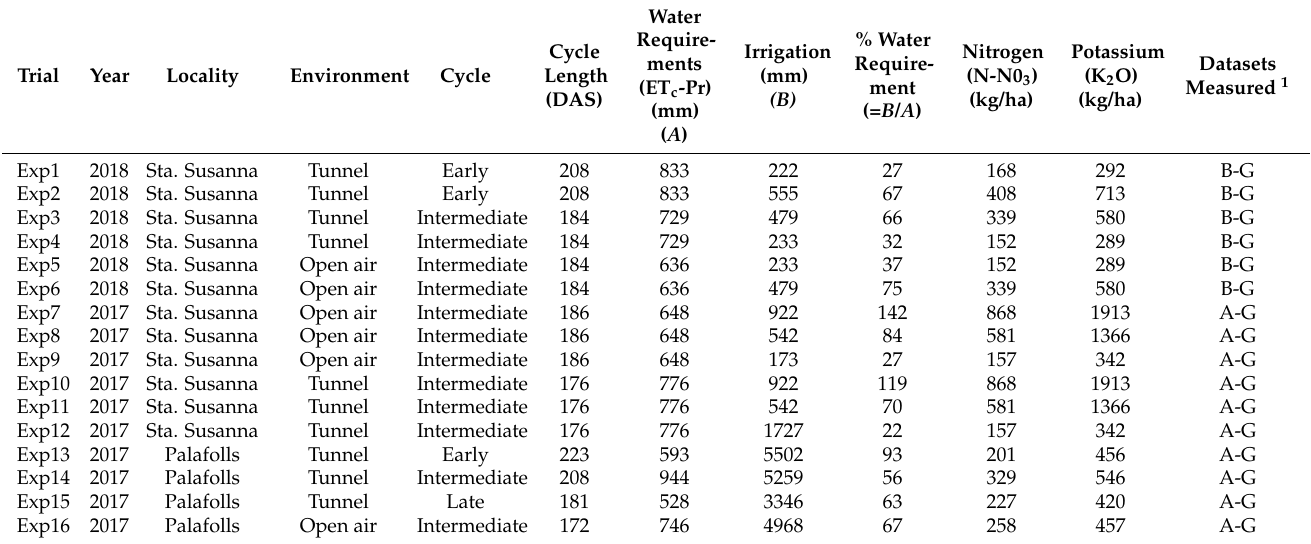
Table 1. Experimental conditions in the 16 experimental trials (DAS = days after sowing; ET c = crop evapotranspiration; Pr =